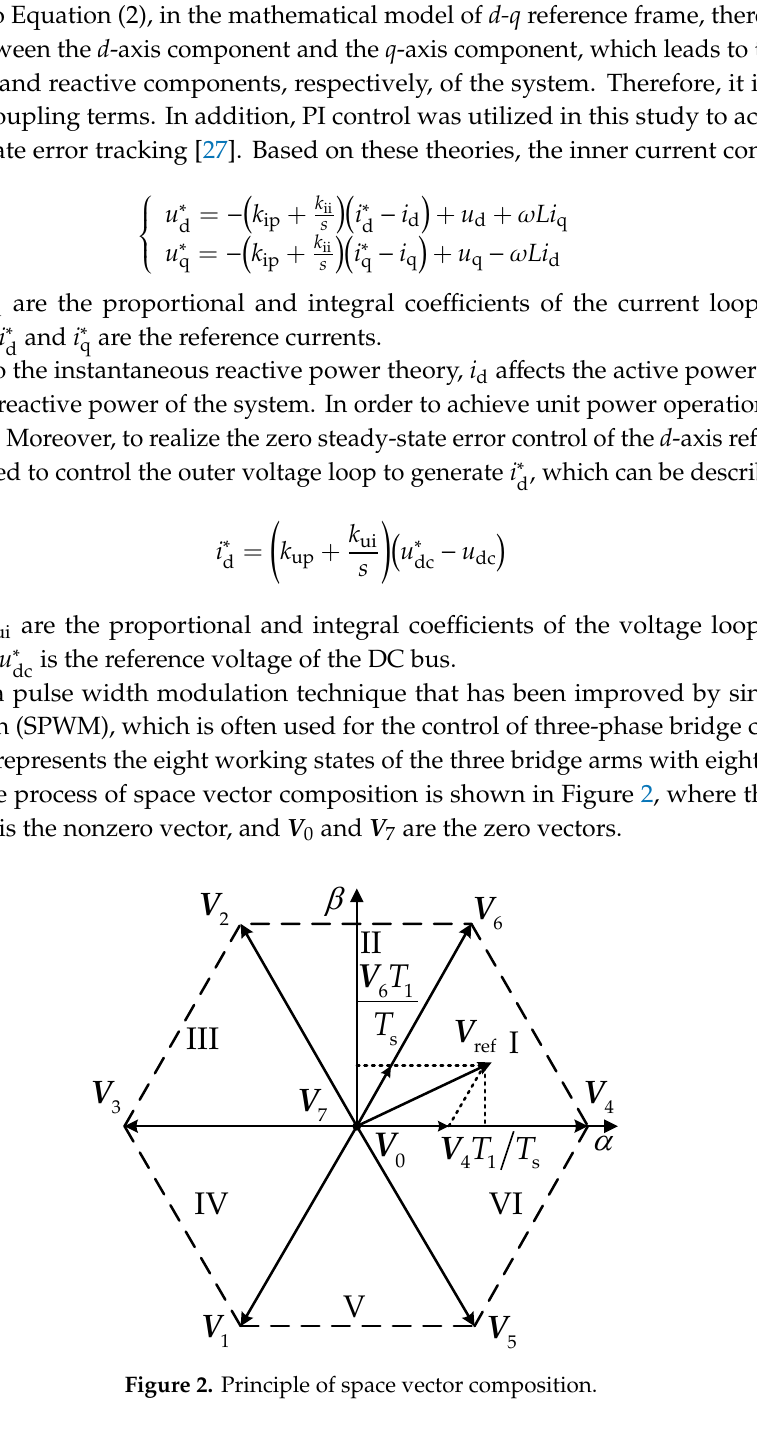
L ω Figure 3. Control block of three-phase PWM converter.